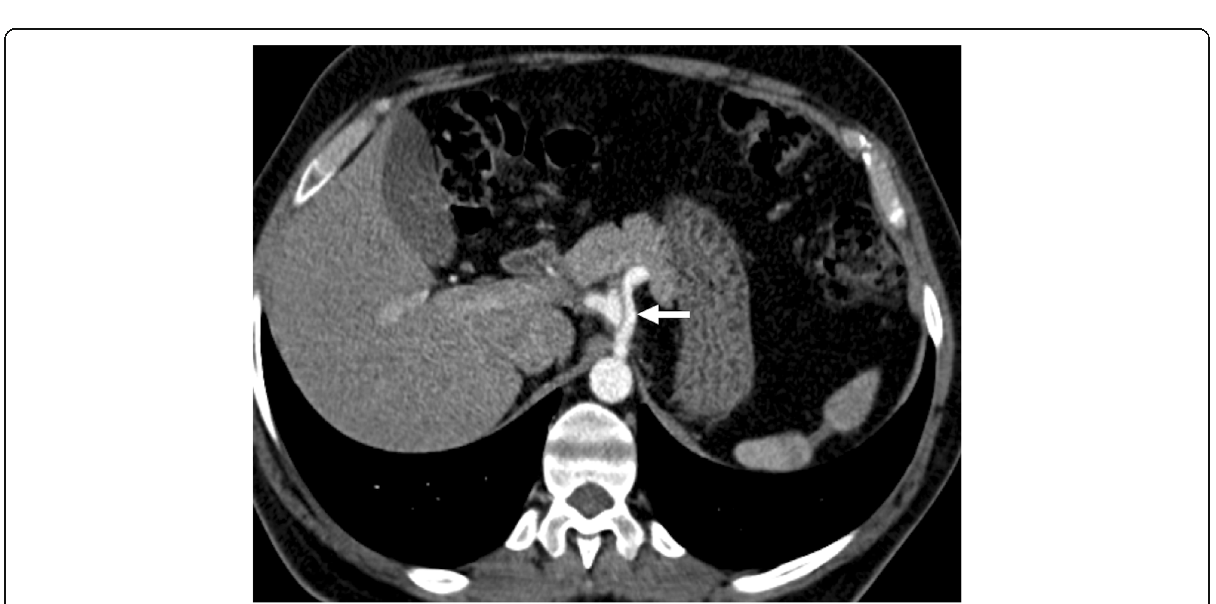
Fig. 25 Celiac artery dissection. A 37-year-old male with known polyarteritis nodosa presented to ED with excruciating epigastric pain. Axial plane post-contrast CT image demonstrates the intimal flap in the celiac trunk consistent with isolated dissection (arrow). There was no associating abdominal aortic